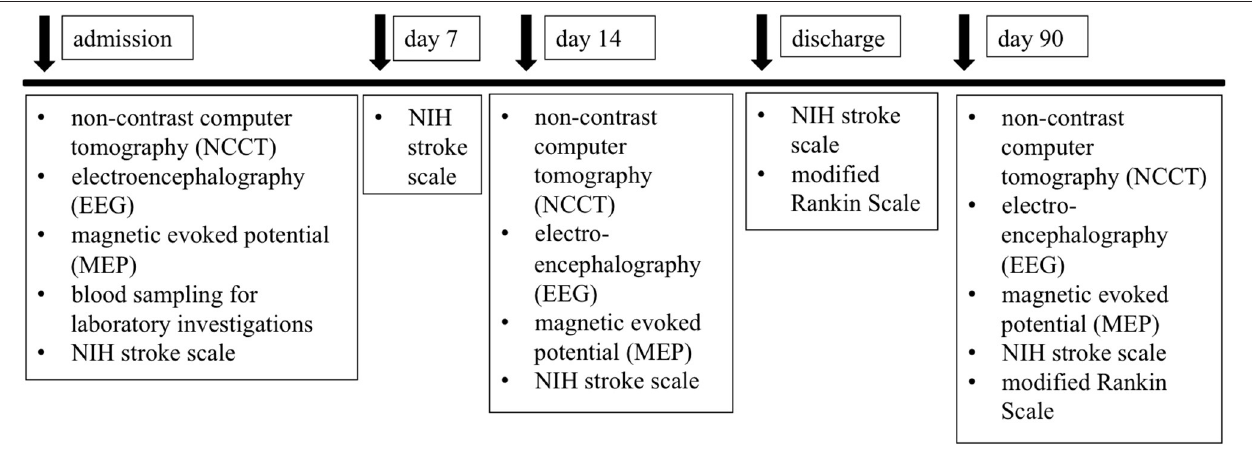
FIGURE 1 | Flow chart of examinations planned during the